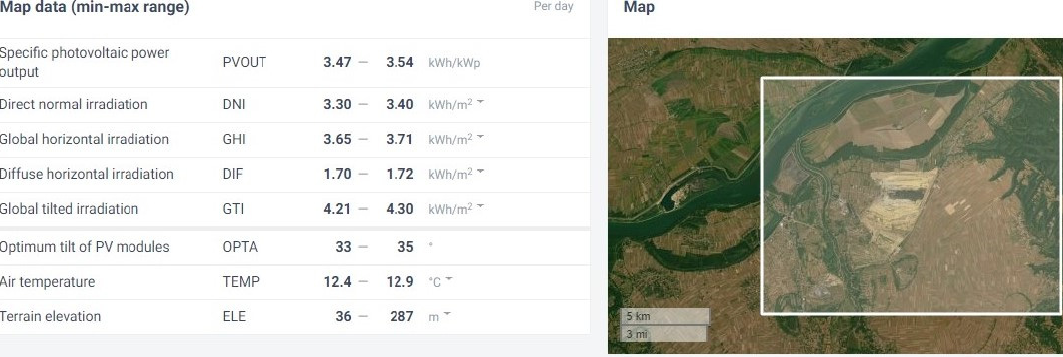
Figure 5. Coal basin Kostolac opencast mine Drmno area photovoltaic possibilities (available flat surface 1800 ha) (data obtained from the “Global Solar Atlas 2.0, a free, web-based application is developed and operated by the company Solargis s.r.o. on behalf of the World Bank Group, utilizing Solargis data, with funding provided by the Energy Sector Man- agement Assistance Program (ESMAP). For additional information: https://globalsolaratlas.info) [9].